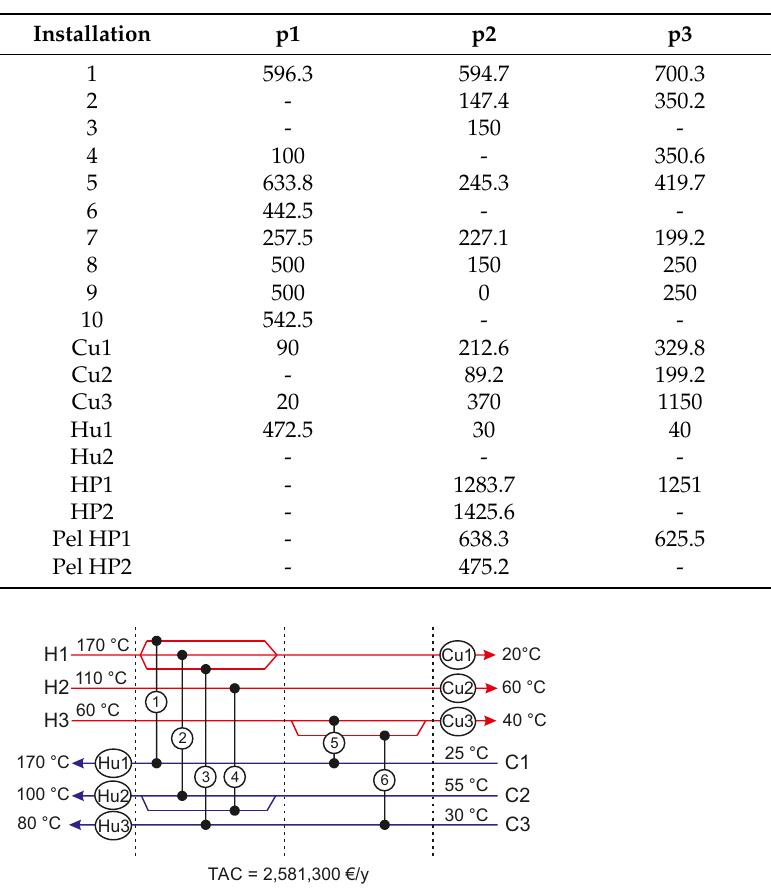
Table 8. Heat Flows and P el results with HP and ST options case 2 (kW).